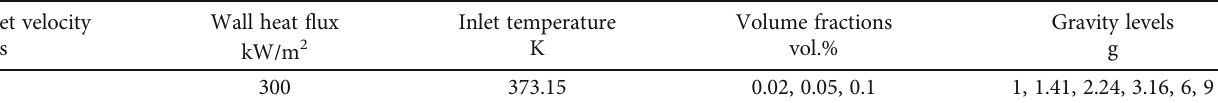
Table 3: Boundary